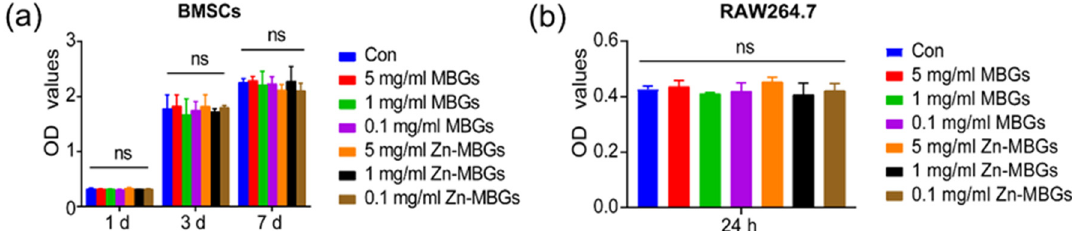
Figure 3. The CCK-8 assay results of BMSCs ( a ) and RAW264.7 cells ( b ) cultured with the extracts of MBGs and Zn-MBGs at different concentrations for one, three, and seven days. NS indicates no significant difference.